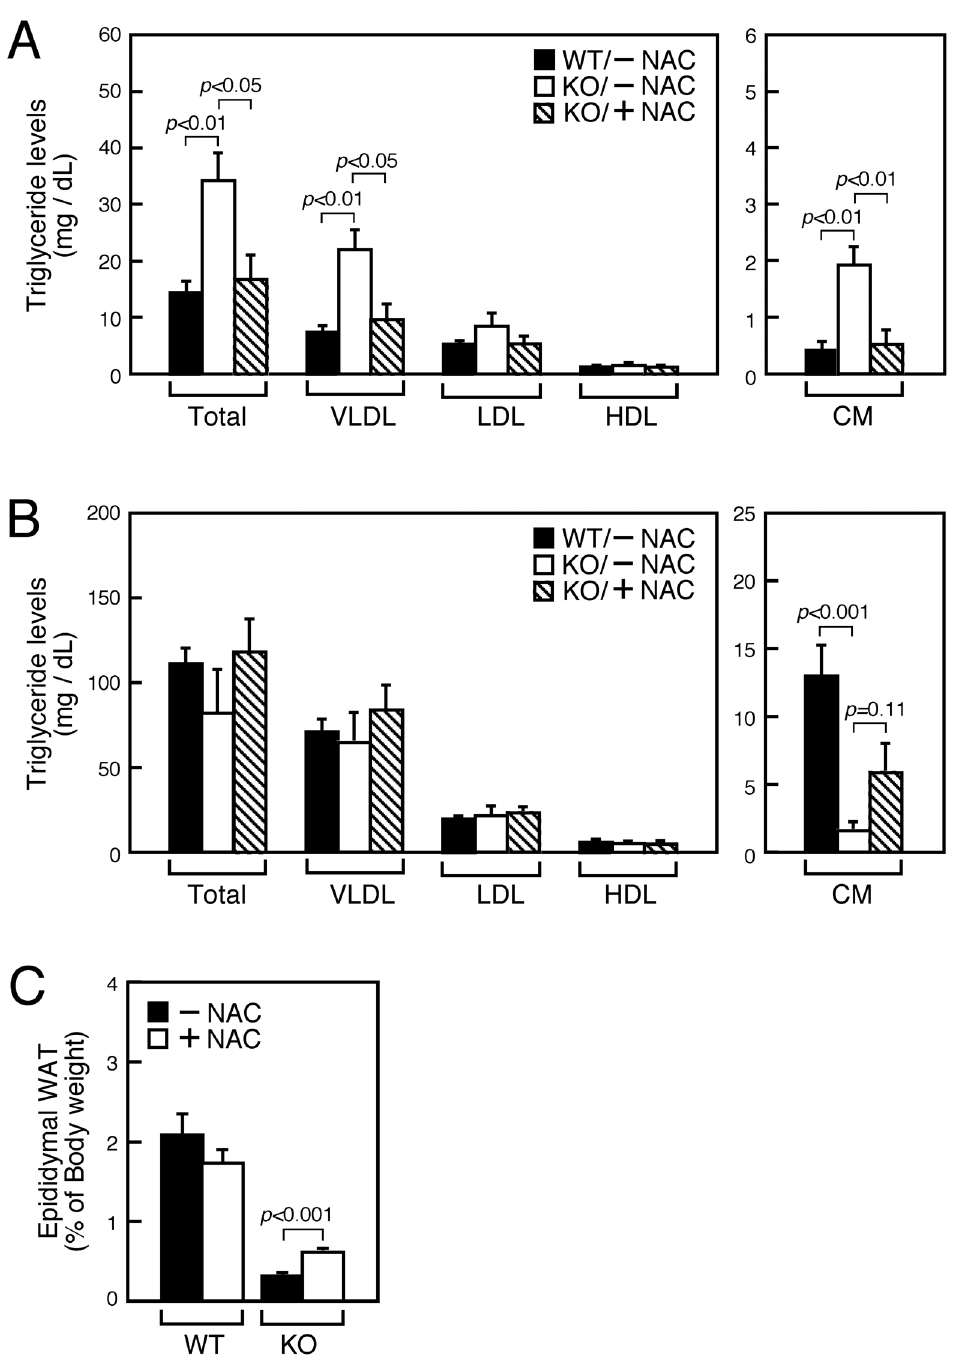
Figure 6. NAC treatment antagonizes WAT deficits seen in SMS1-KO mice. Mice supplied normal ( 2 NAC) or NAC-containing ( + NAC) drinking water were analyzed as follows. (A) Blood plasma isolated from 4 h-fasted mice (20-week-old) was subjected to lipoprotein analysis (WT/ 2 NAC, n =5; KO/ 2 NAC, n =4; KO/ + NAC, n =6). CM, chylomicron; VLDL, very-low-density lipoprotein; LDL, low-density lipoprotein; HDL, high-density lipoprotein. (B) Ten-week-old mice supplied normal ( 2 NAC) or NAC-containing ( + NAC) drinking water were subjected to 30 h-fasting. Blood plasma was collected and subjected to lipoprotein analysis. n =9–10 mice per group. (C) Measurement of epiWAT size of 10-week-old mice. n =10 samples per